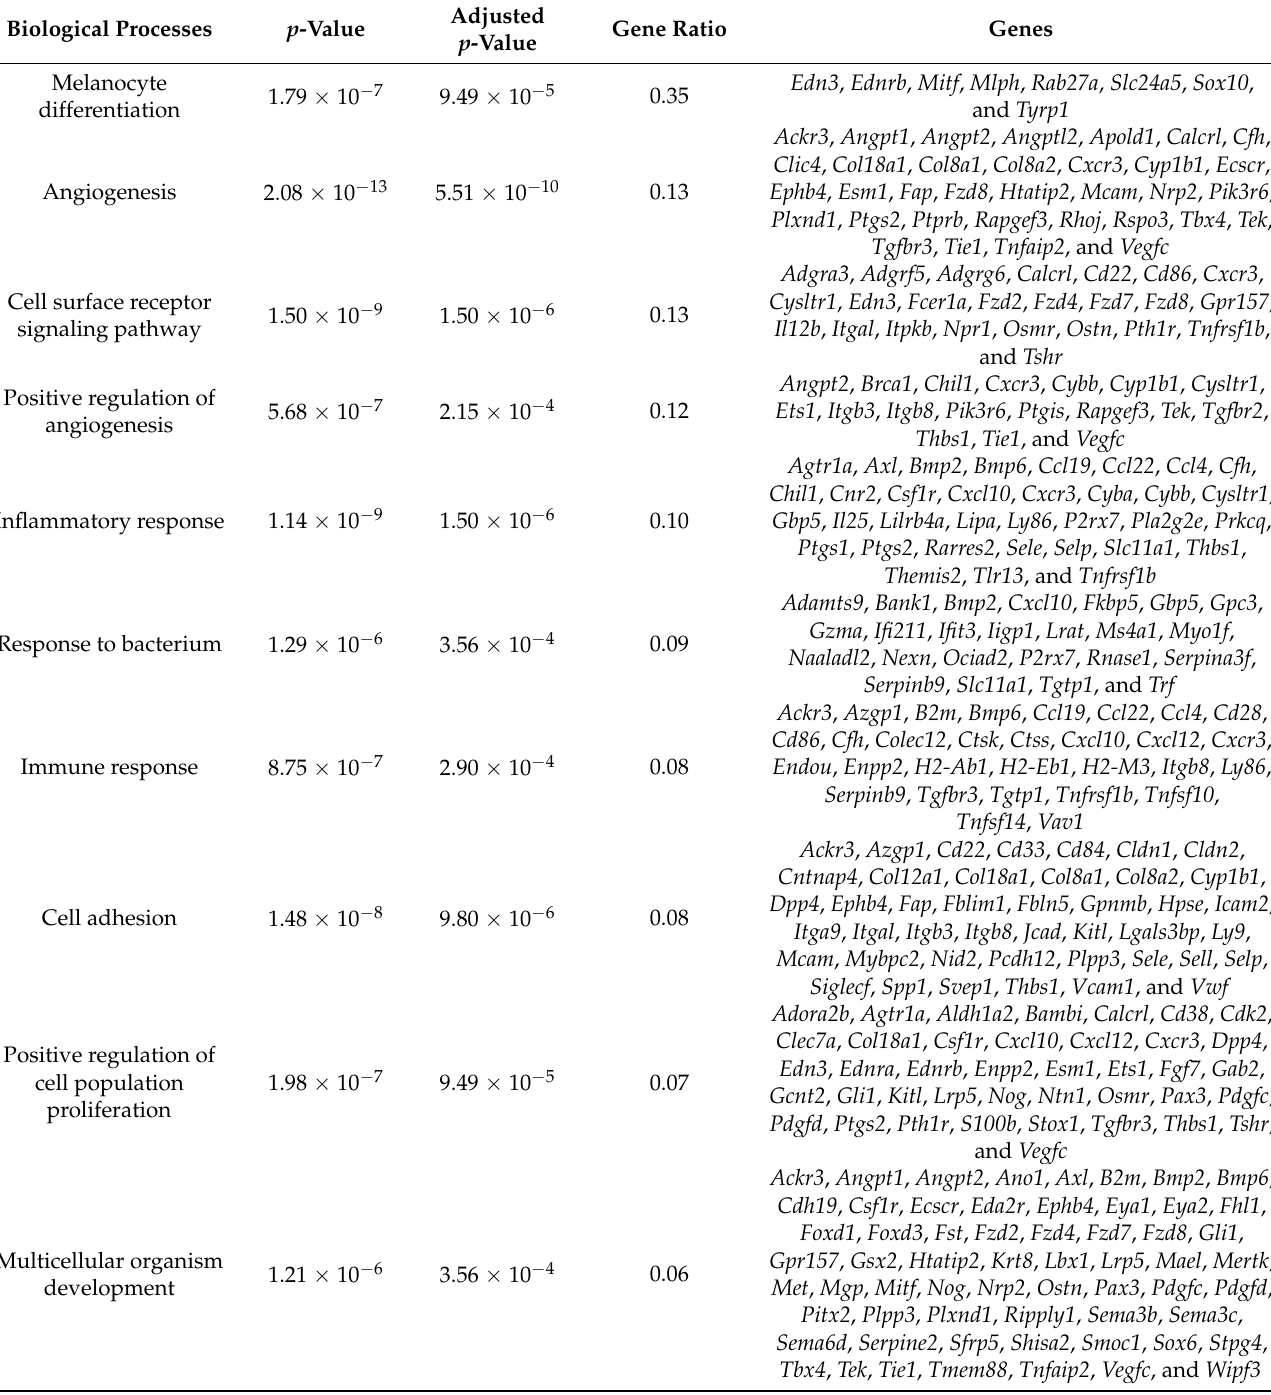
Table 2. Top 10 biological processes upregulated by high-fat diet